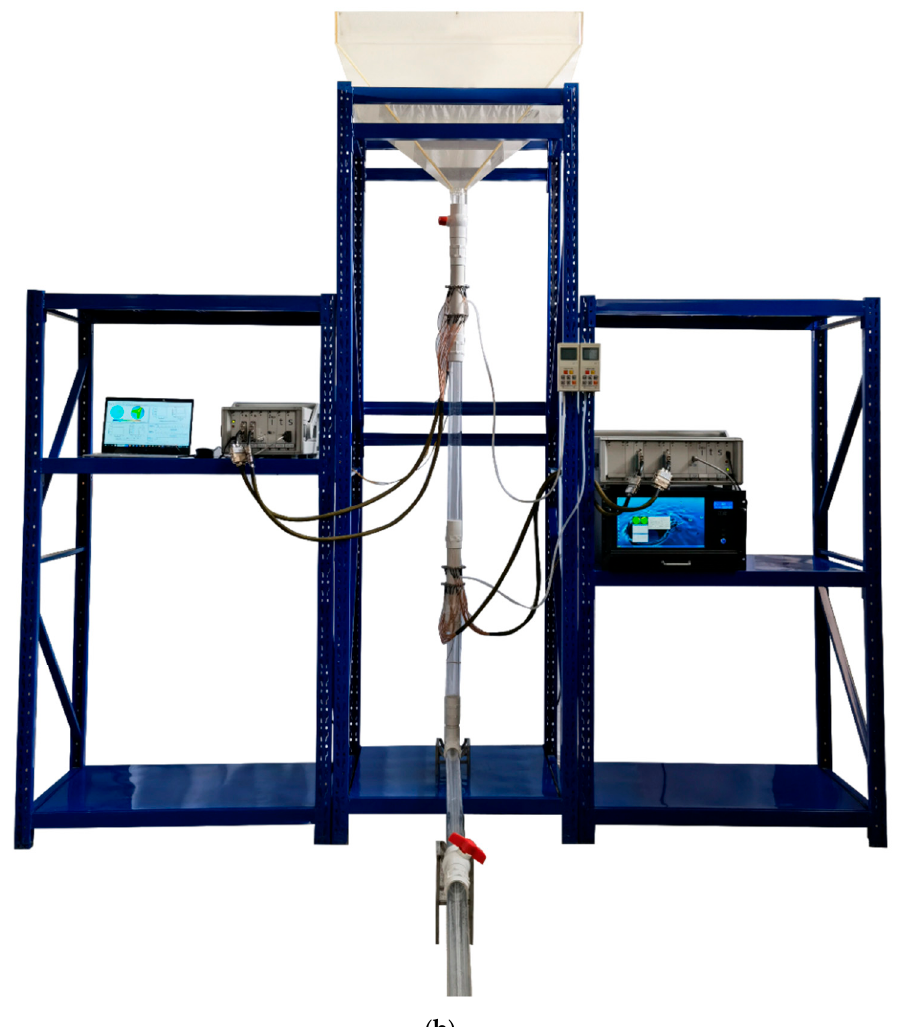
Figure 4. Gravity flow experimental setup. ( a ) Schematic drawing; ( b ) photograph.